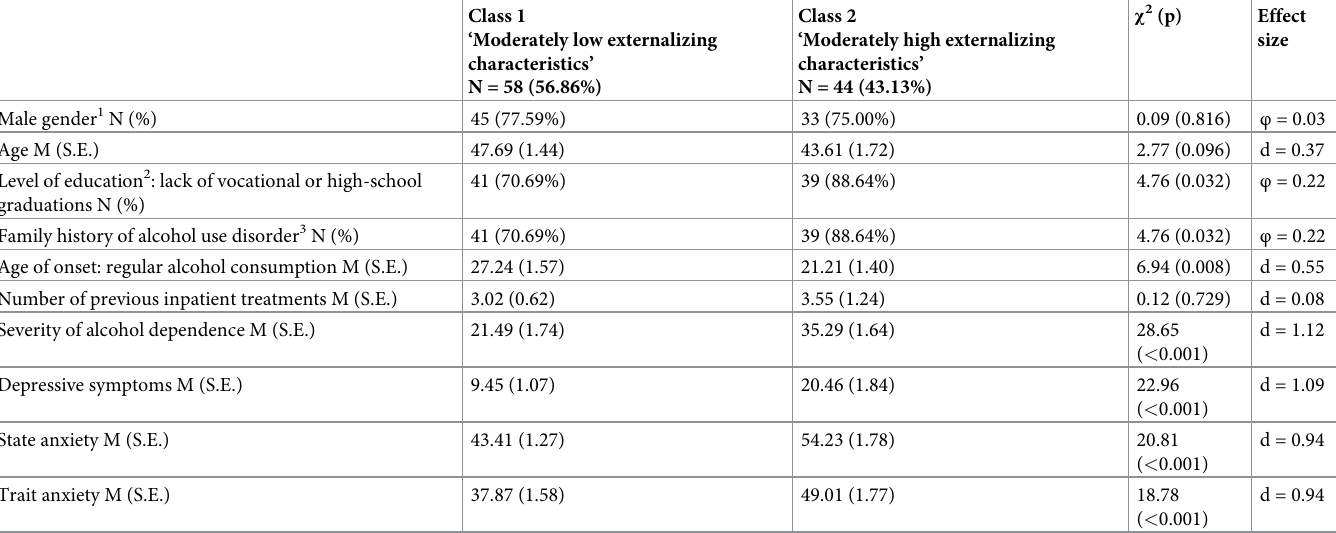
Table 2. Comparison of latent classes in terms of demographic and anxio-depressive variables.